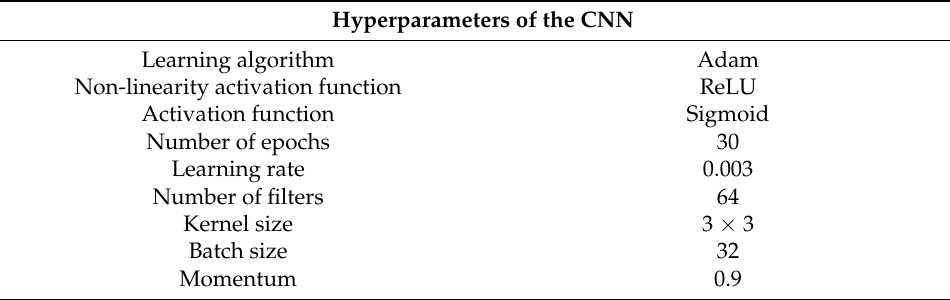
Table 6. CNN structure